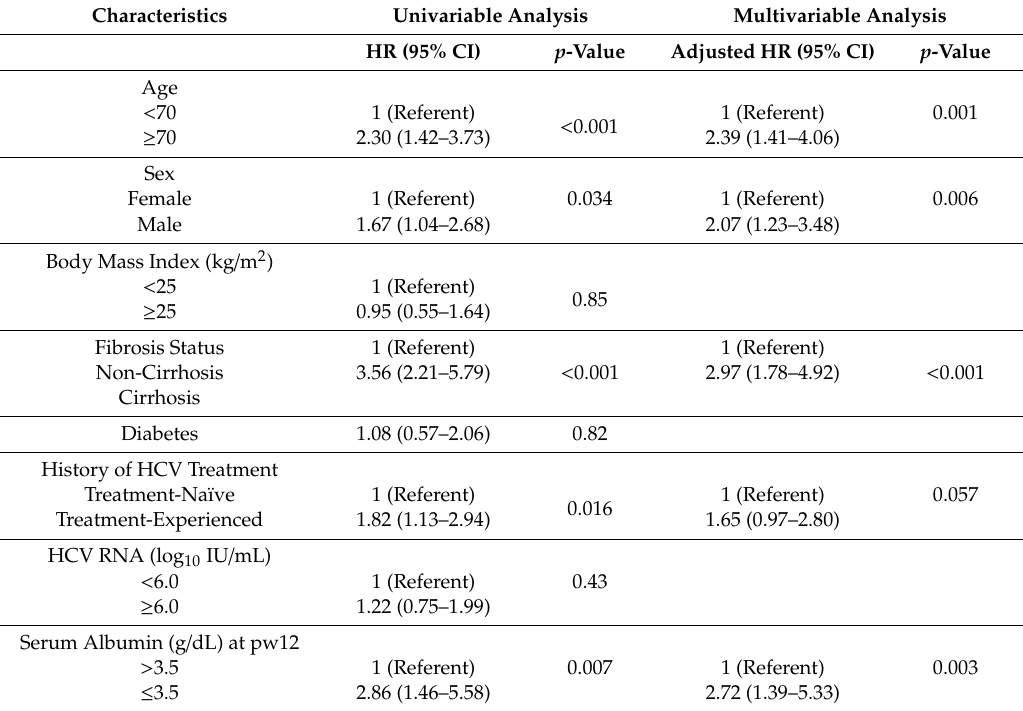
Table 3. Predictors of hepatocellular carcinoma development in the propensity score matched